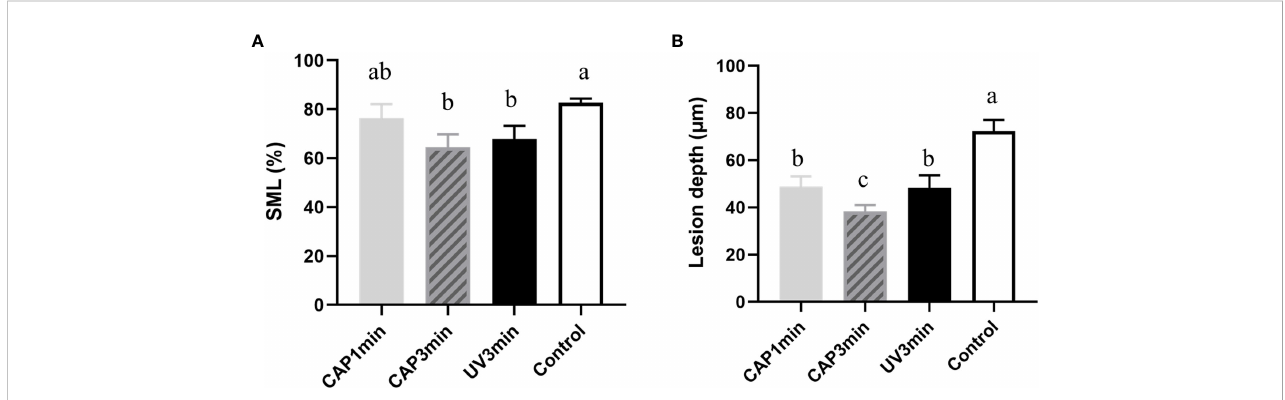
FIGURE 9 (A) Surface microhardness loss of enamel blocks after treatment followed by a 16-h acid attack. (B) Lesion depth after treatment followed by the 16-h acid attack ( P < 0.05).